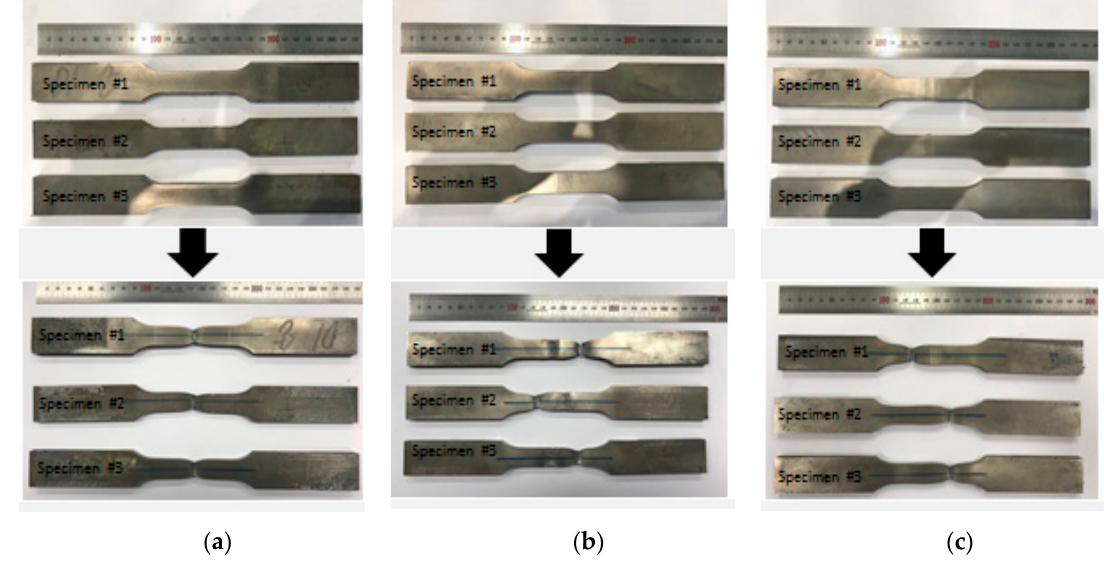
Figure 5. Specimen after test for tensile strength each welding process. ( a ) Base metal (A553-1); ( b ) FCAW weldment; ( c ) LBW weldment.